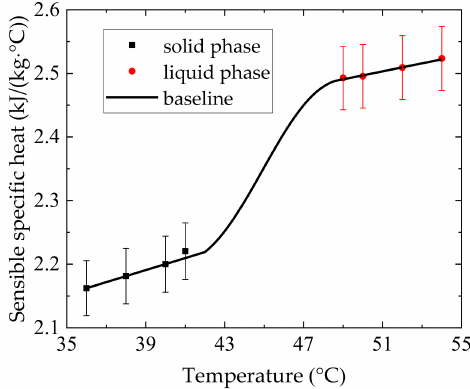
Figure 12. Sensible specific heat value of